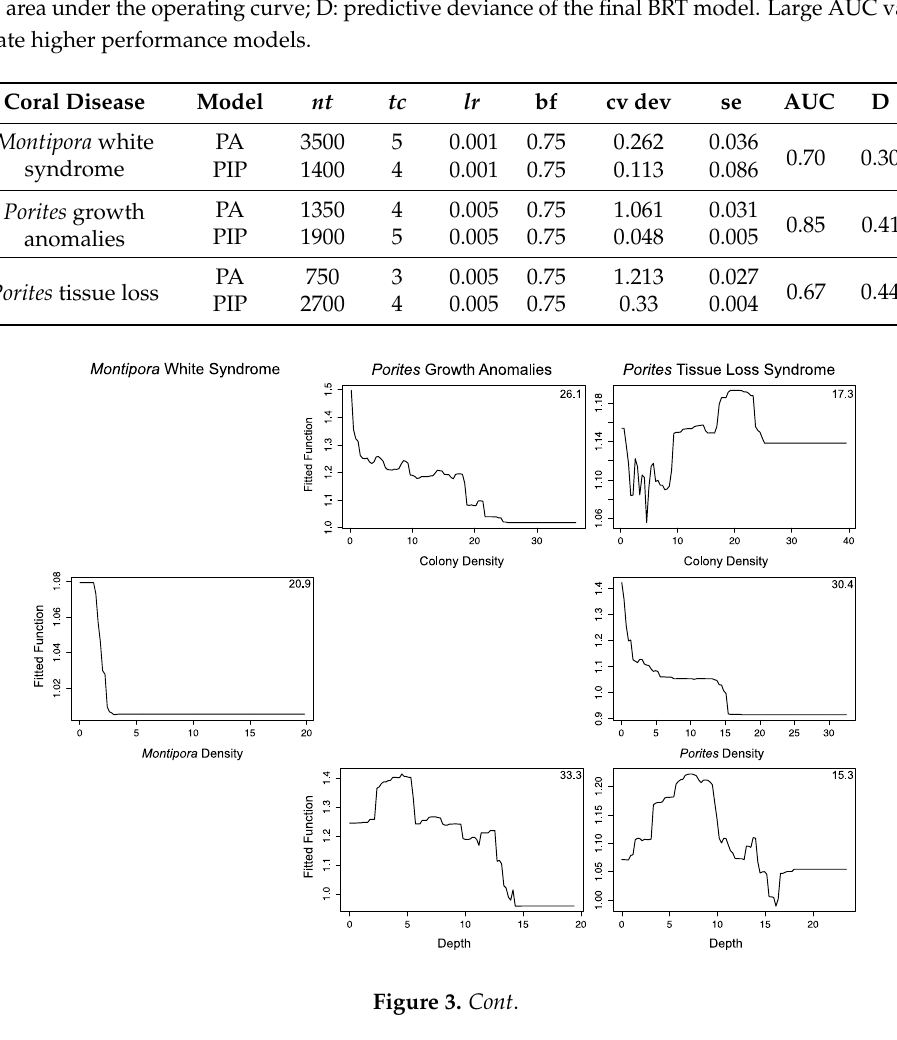
Table 2. Optimal setting and predictive performance of boosted regression tree analyses for three